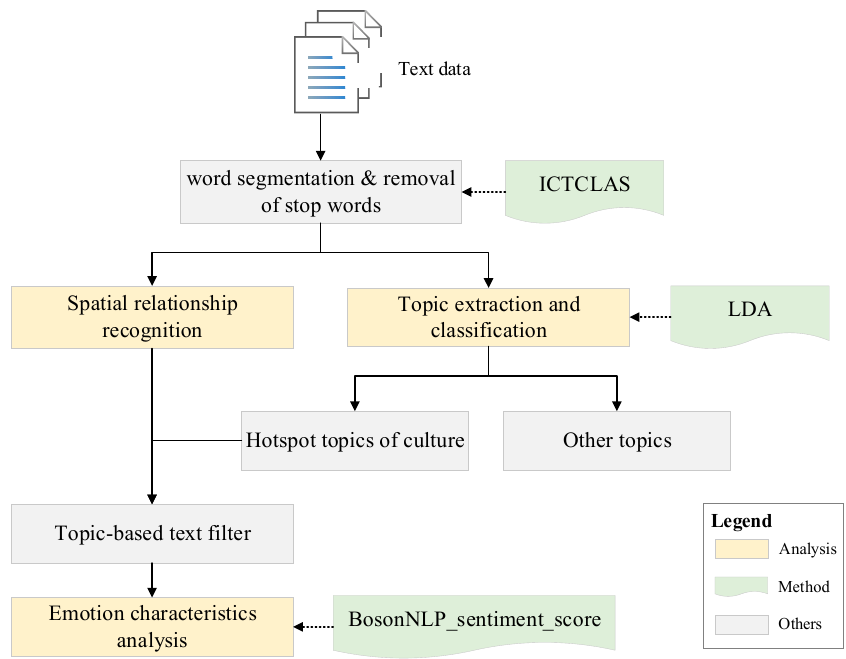
Figure 2. Work flow of data processing and analysis.